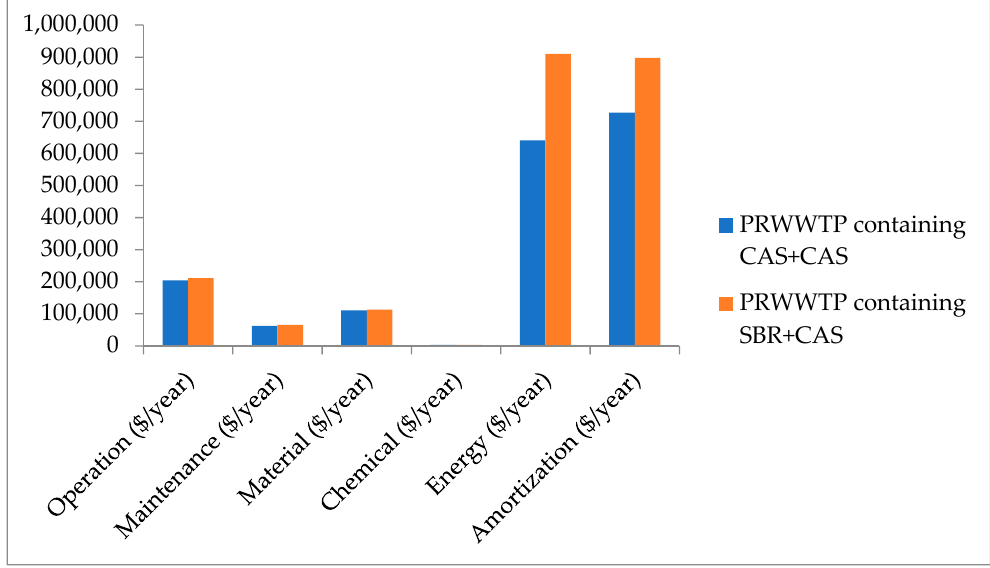
Figure 6. The total operation, maintenance, material, chemical, energy, and amortization costs ($/year) of the PRWWTPs containing CAS + CAS and SBR + CAS processes.